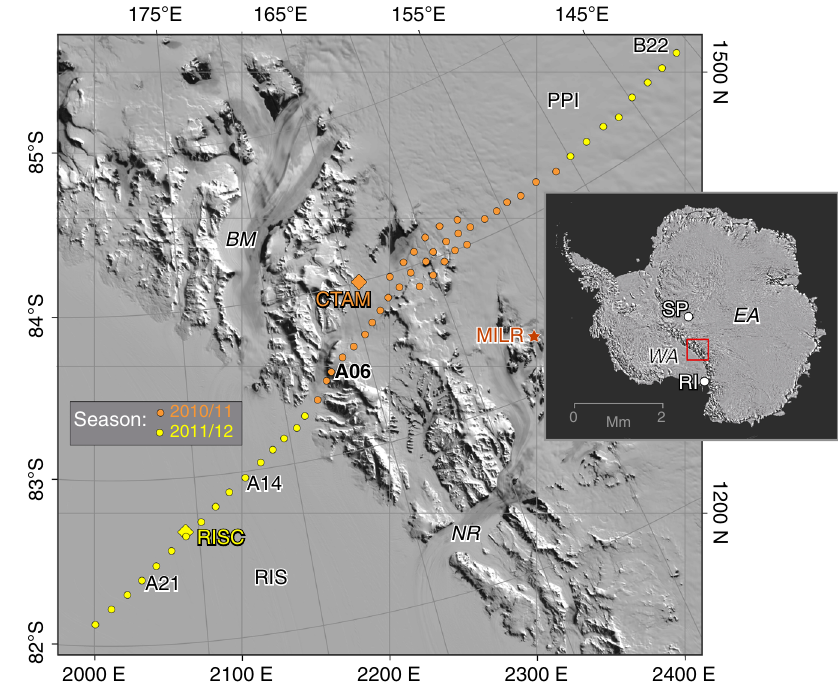
Fig. 1 MT site locations across the central TAM and surroundings. Locations and physical features are plotted using a MODIS satellite base map 72 . Grid north is up and both latitude – longitude and Universal Polar Stereographic (UPS) coordinates are overlain on main panel. Orange diamond denotes CTAM multi-investigator camp location active during 2010 – 11 austral summer season (orange sites), whereas yellow diamond denotes Ross Ice Shelf fi eld camp (RISC) for 2011 – 12 season (yellow sites). Speci fi c sites discussed in text are labeled. The sole passive seismic station 22, 23 within the fi eld of view is MILR. Beardmore and Nimrod glaciers are BM and NR, whereas RIS and PPl are Ross Ice Shelf and Polar Plateau, respectively. Within the TAM, the MT transect lies along the lesser Law – Walcott – Lennox – King glaciers. In the inset, WA and West Antarctica, EA is East Antarctica, SP is South Pole, and RI is Ross